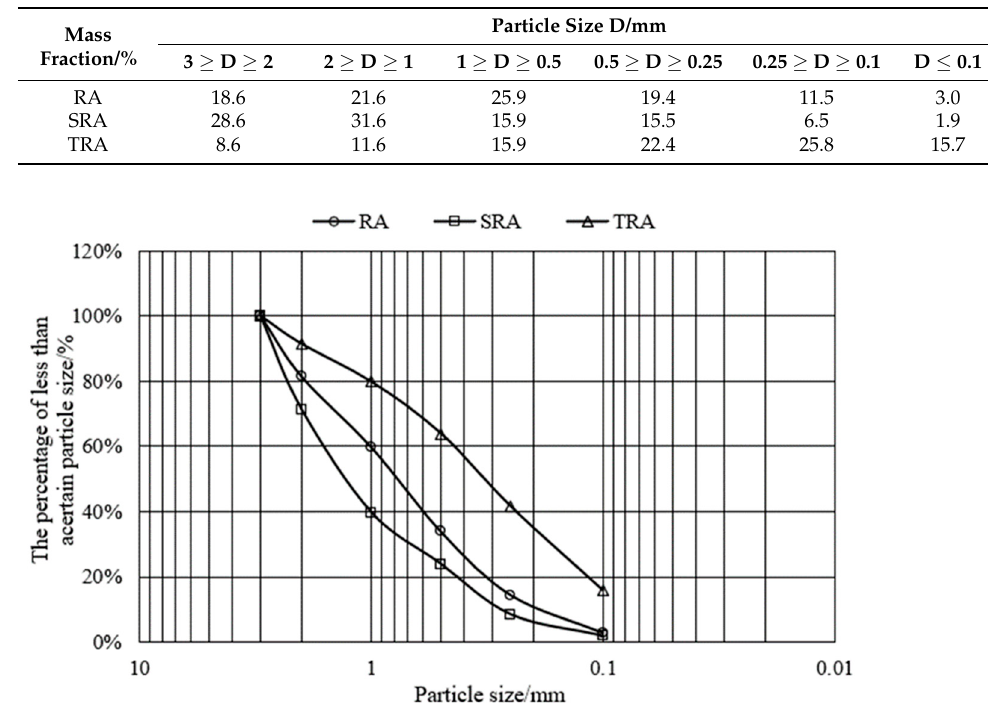
Table 4. Mass fraction of recycled aggregates of different grades under each particle size.